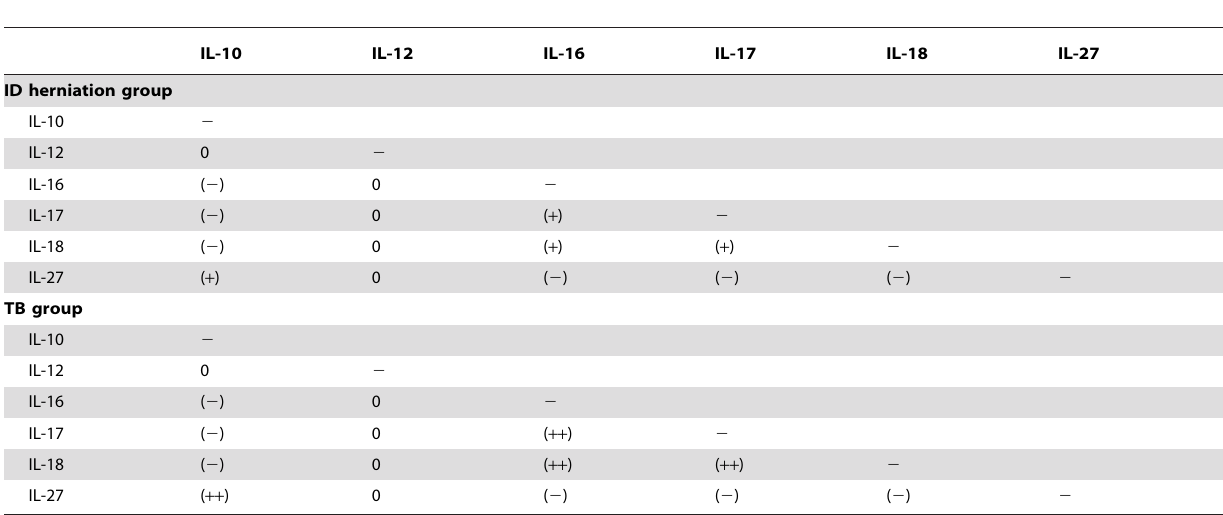
Table 6. Correlation table demonstrating the pairwise co-expression profile of ILs in the ID herniation and TB group.